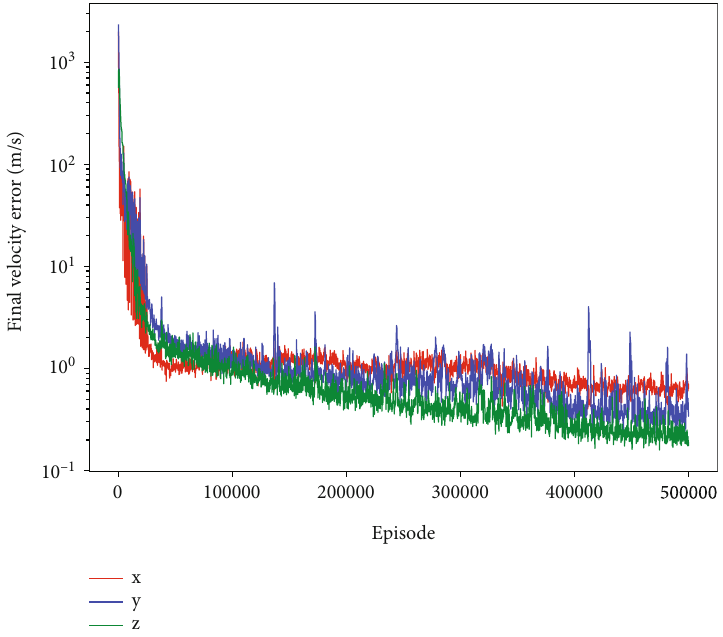
Figure 4: Learning curves for fi nal velocity